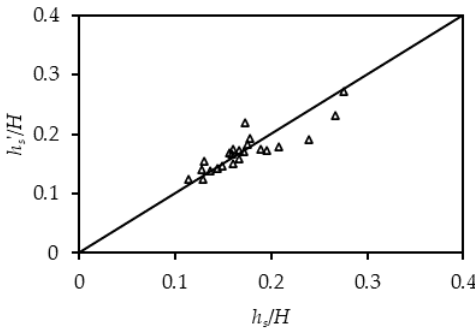
Figure 17. Comparison of the ratio of calculated maximum scour depths to H to those of the measurements.